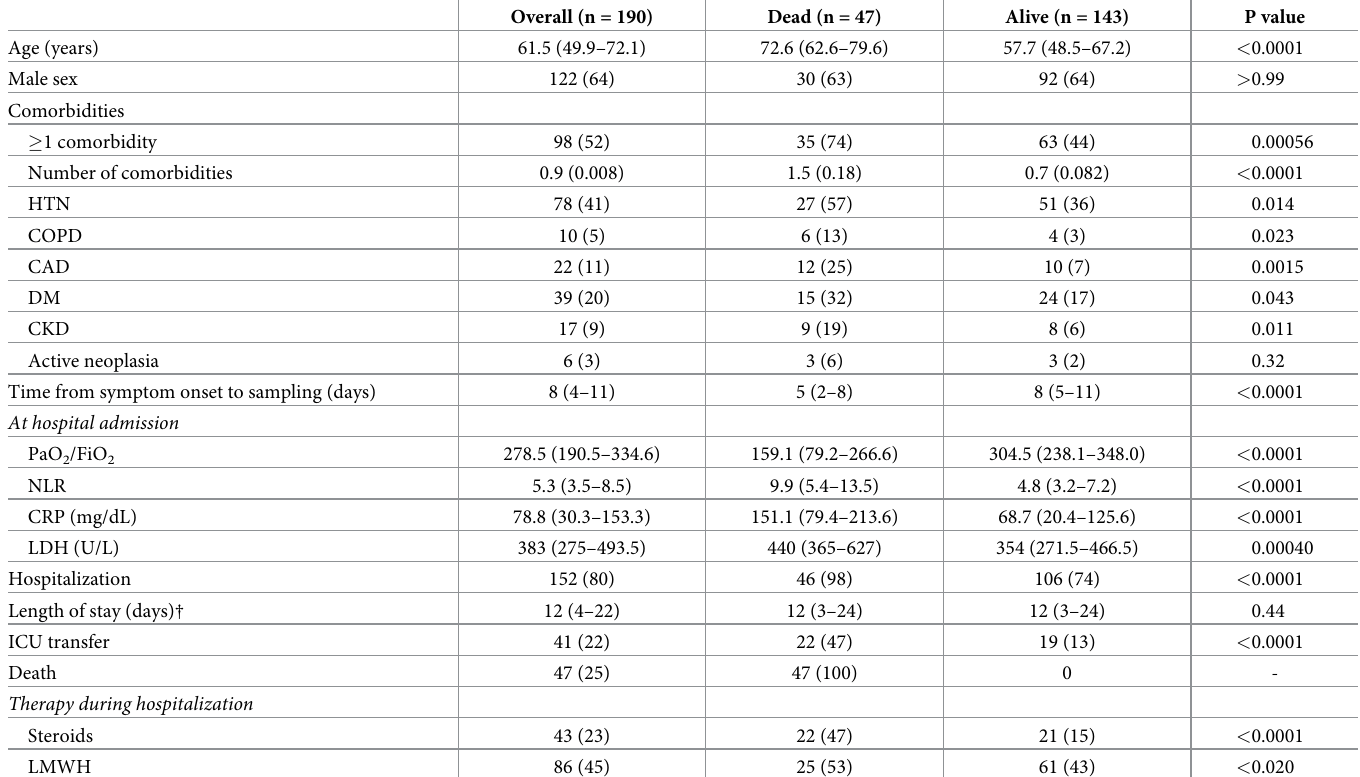
Table 1. General and disease characteristics of COVID-19 patients.